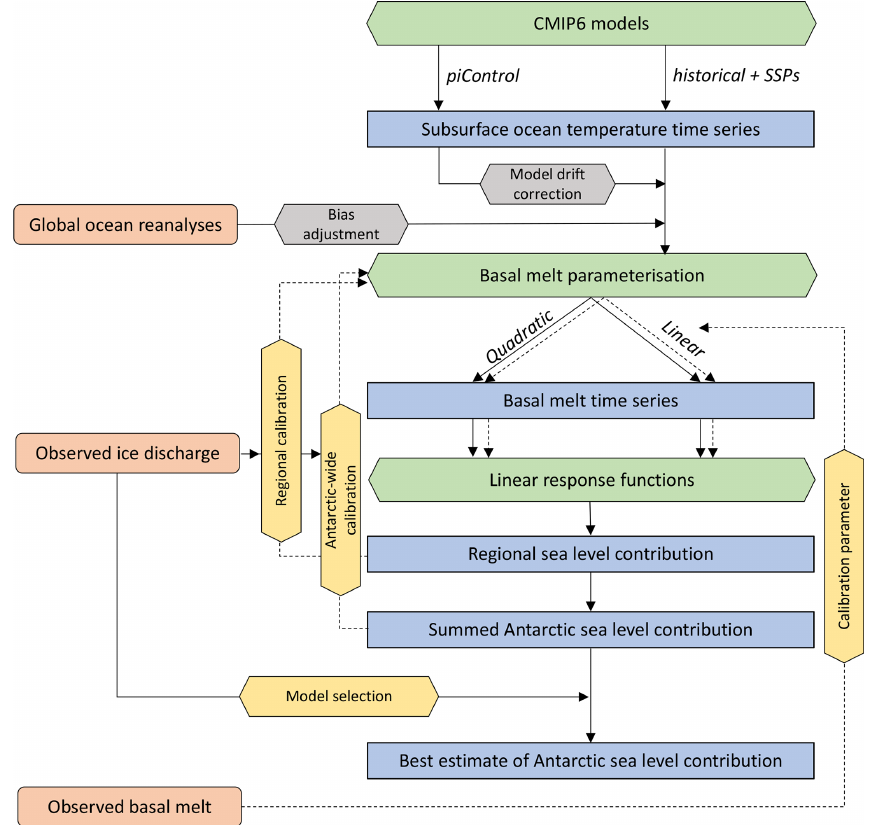
Figure 1. Flow diagram of procedure. Observational constraints are indicated in orange, main computations of the Levermann et al. (2020) method in green (including model experiments by the modelling groups), calibration methods in yellow, bias adjustments in grey and (intermediate) output data in blue. The continuous lines represent direct pathways while the dashed lines refer to iterative processes or optional choices during calibration.